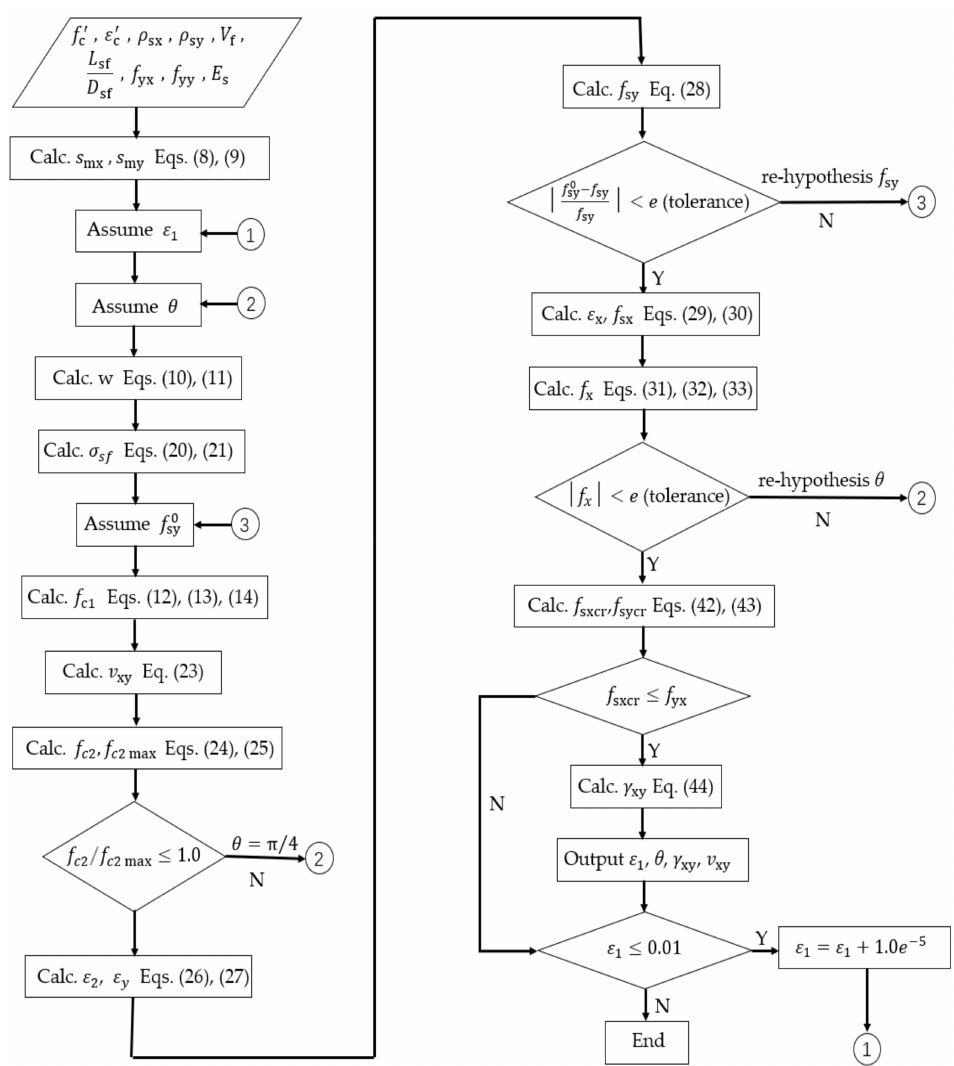
Figure 10. Flow chart showing an efficient algorithm.